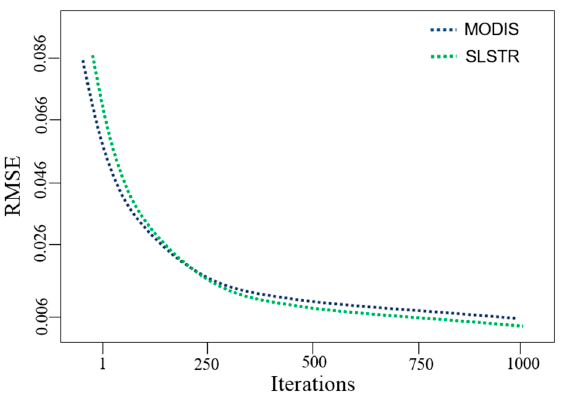
Figure 4. Relationship between the root mean square error (RMSE) and the number of iterations for the parameters (C and γ ) for pre-establishment of the SVM classifier obtained from different subsets of training sample data.